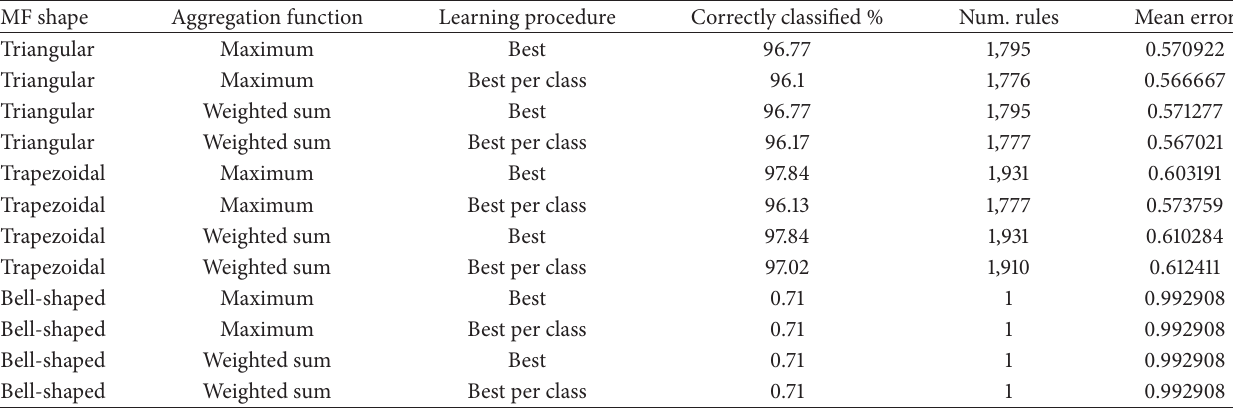
Table 1: Round 1. Data not separated by gender for any species; 2,820 patterns presented for use in training; NEFCLASS-J defaults for learning constraints and learning rate were kept; maximum number of epochs was 500, minimum number of epochs was 10, and number of epochs after optimum was 25.